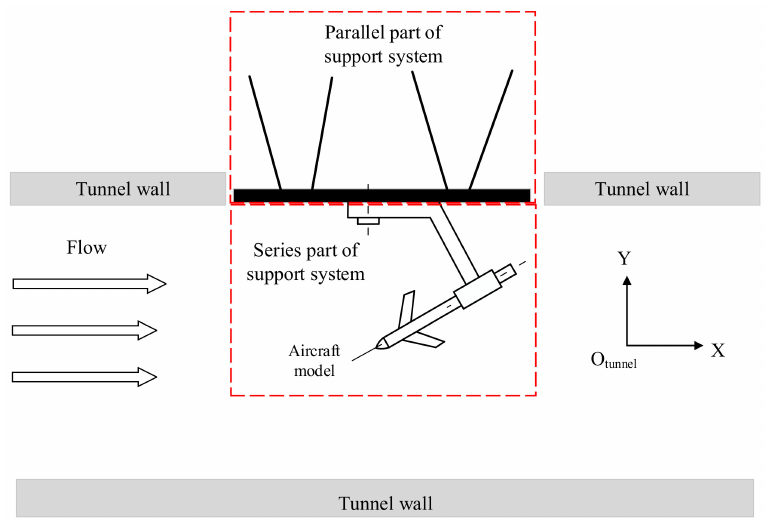
Figure 1. Aircraft model support system in the wind